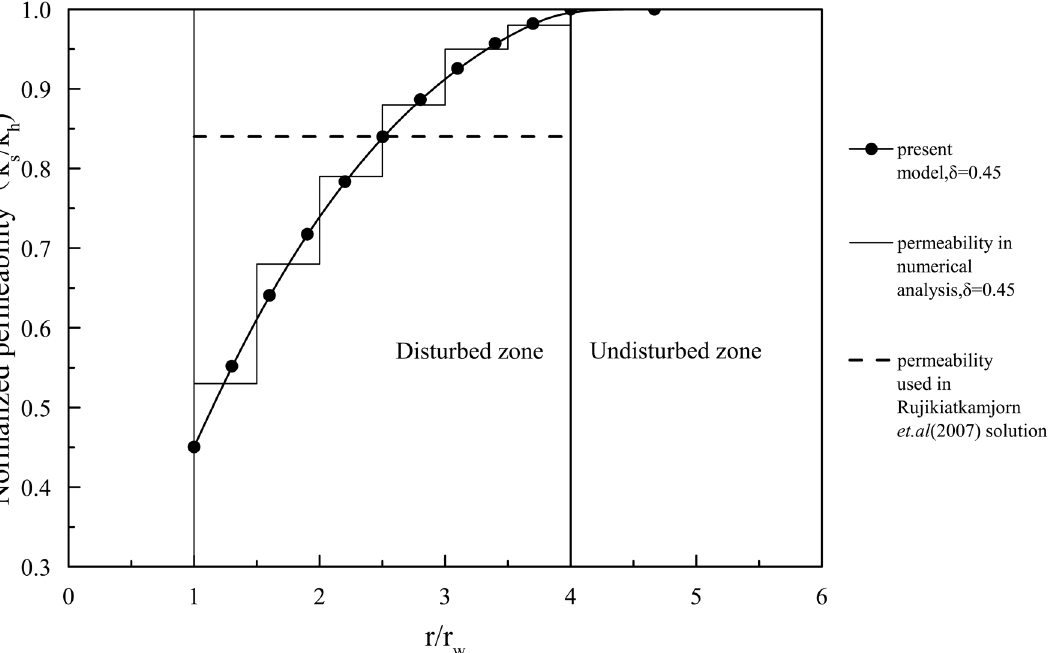
Fig 4. Permeability coefficients of the present model and numerical analysis ( δ = 0.45) and of the study by Rujikiatkamjorn et